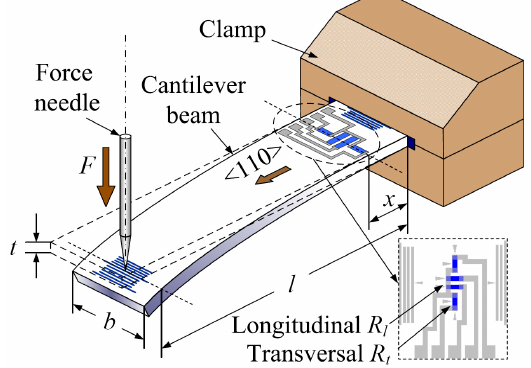
Figure 5. Schematic diagram of test setup for measuring gauge